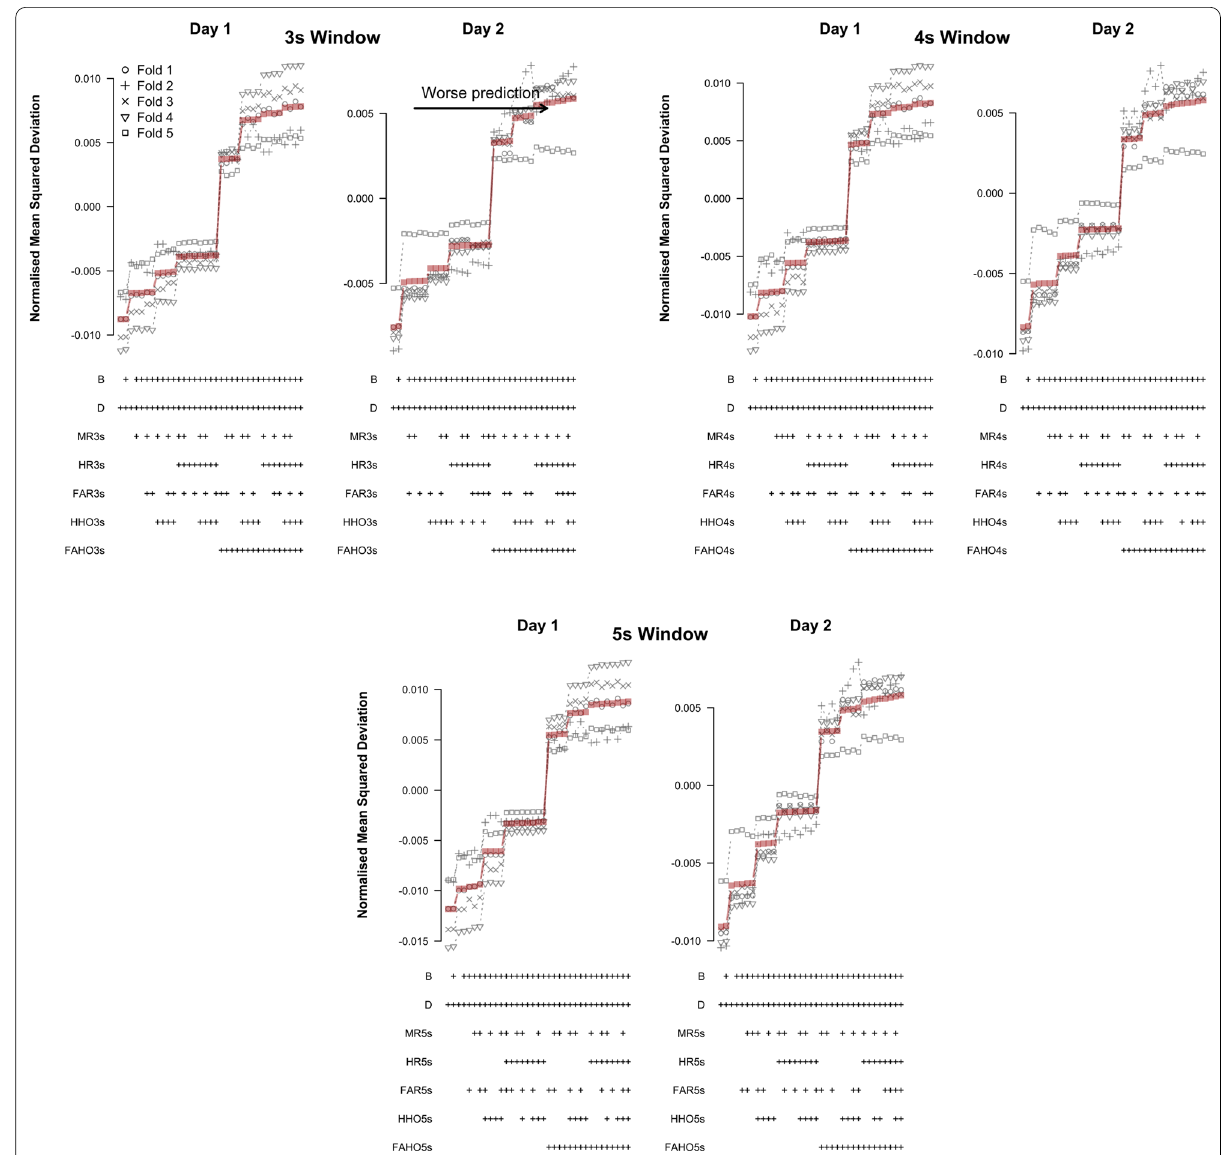
Fig. 9 Cross-validation results based on binomial-family GLMs for different UAV-task event predictors of omissions. Normalized mean squared deviations for different binomial family generalized linear mixed effect models for different time windows prior to the DRT prompt are shown. Top row: 3-s time window; middle row: 4-s time window; bottom row: 5-s time window. Left column: results for day 1; right column: results for day 2. Red squares show the mean across